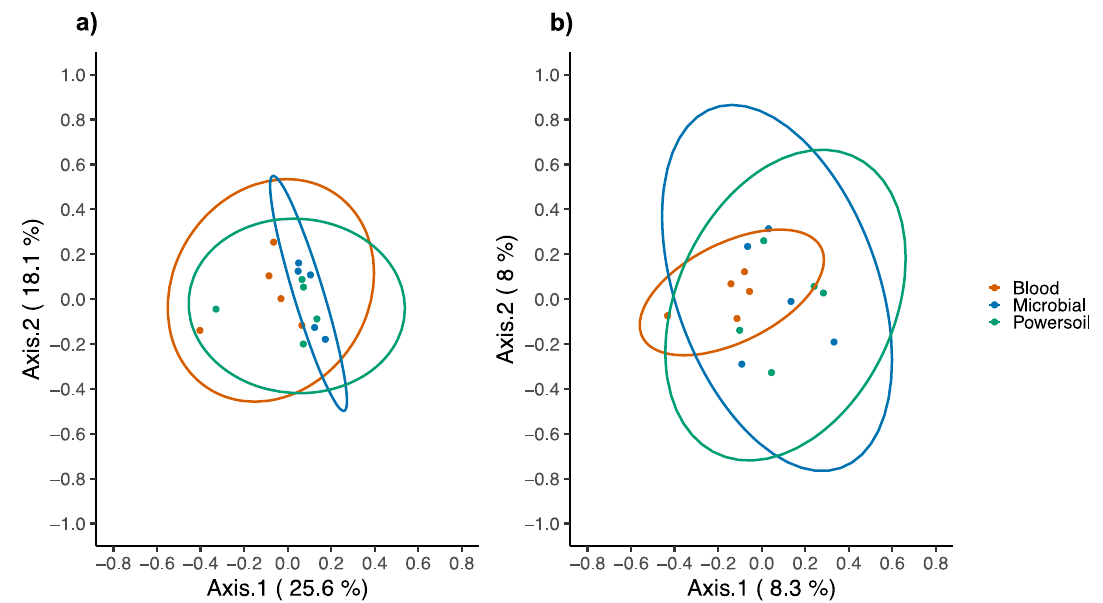
Fig. 3 Principal coordinates analysis of the extraction controls by extraction kits. a Based on Weighted Bray-Curtis Distances. b Unweighted Bray-Curtis Distances. Data ellipses were computed on multivariate t -distribution at 95%. The colors of the ellipses represent the three different DNA extraction methods used; n = 5 negative controls per method (total of 15).